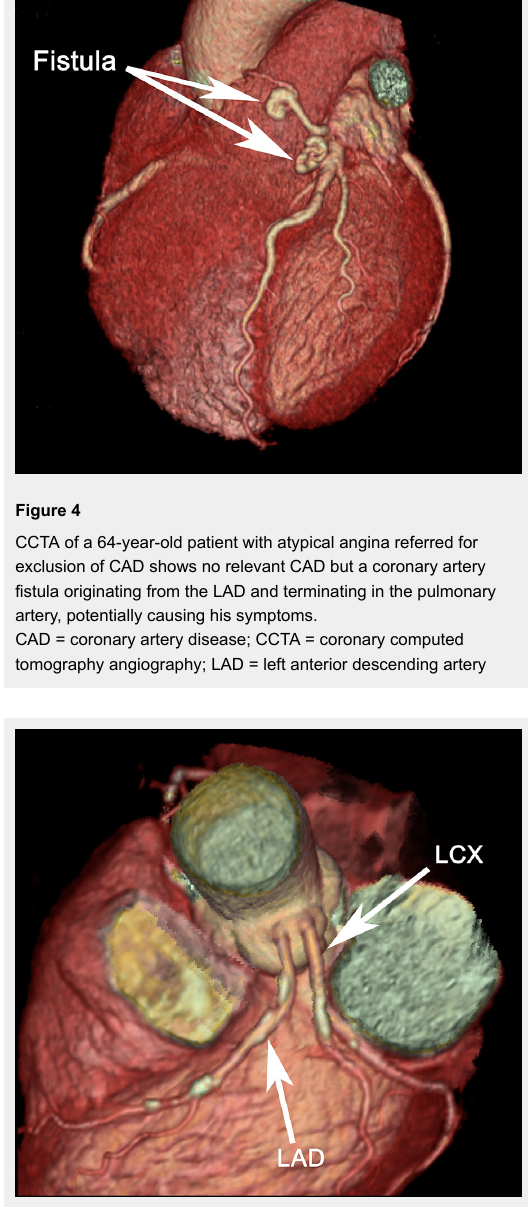
CCTA of a 63-year-old male shows obstructive CAD and absent left main stem with separate ostium for LAD and LCX. Absent left main stem is considered a benign variant of CAA, but the finding may be of clinical importance for eventual revascularisation procedures. CAA = coronary artery anomaly; CAD = coronary artery disease; CCTA = coronary computed tomography angiography; LAD = left anterior descending artery; LCX = left circumflex coronary